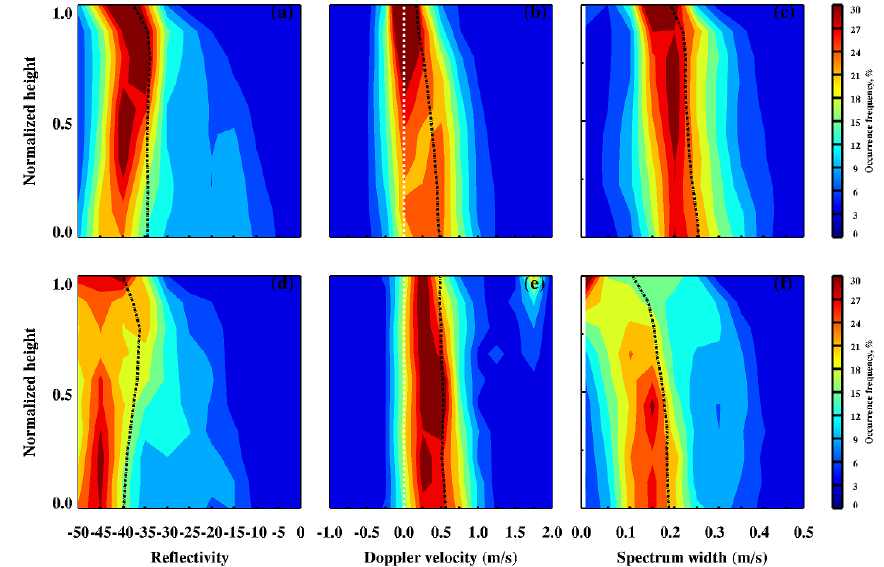
Figure 12. Same as Fig. 11 but only for mixed-phase (a–c) and ice (d–f) clouds over the south of 60 ◦ S during MARCUS.